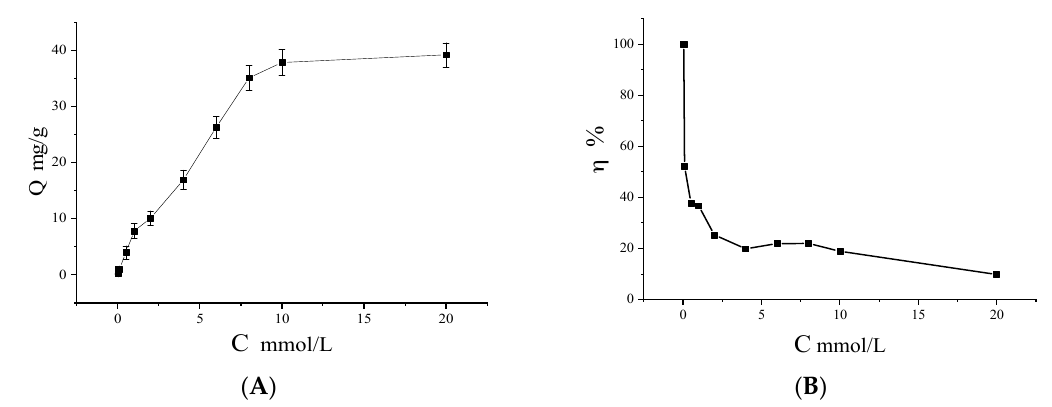
Figure 9. Adsorption isotherms ( A ) and removal rate ( B ) of Cu(II) on the MNPs. Adsorption conditions: V = 1.0 mL, m = 3.0 mg, C i = 0–20 mmol/L, time 2 h, temperature 15 °C, pH 7.0.